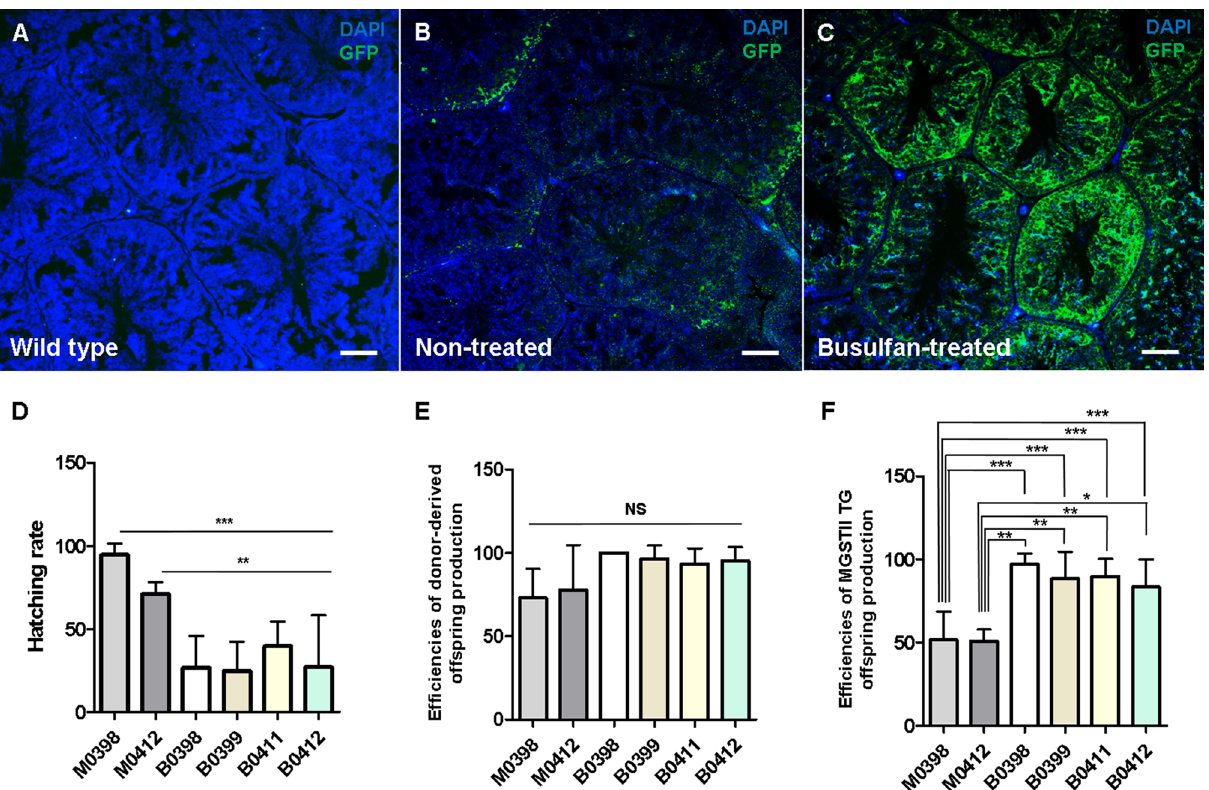
Figure 4. Improved transgenic chicken production rate after busulfan injection. ( A–C ) Cross-sections of testes from adult germline chimeras, and detection of GFP-expressing donor germ cells in adult germline chimeric testes with or without busulfan treatment. ( A ) WT rooster testes were used as a negative control. GFP expression was not observed. ( B ) Testes of germline chimeric roosters without busulfan treatment. GFP + cells were sparsely distributed adjacent to the basement membranes of seminiferous tubules. ( C ) Testes from germ chimeric roosters 2 weeks after busulfan treatment. GFP + cells were present throughout the seminiferous tubules. DAPI was used to stain nuclei in each panel. Scale bars, 200 μm (upper panel) and 50 μm (lower and smaller panel). ( D–F ) Analysis of progeny production rates of germline chimera for 8 weeks. ( D ) Hatching rate of G 1 offspring from germline chimeras with or without busulfan treatment. ( E ) Efficiencies of donor- derived offspring production with or without busulfan treatment. ( F ) Efficiencies of MGSTII-tg offspring (G 1 ) production with or without busulfan treatment. Data are presented as means ± SD from each independent group (progeny production of each week) for 8 weeks. * P < 0.05, ** P < 0.01, *** P < 0.001.